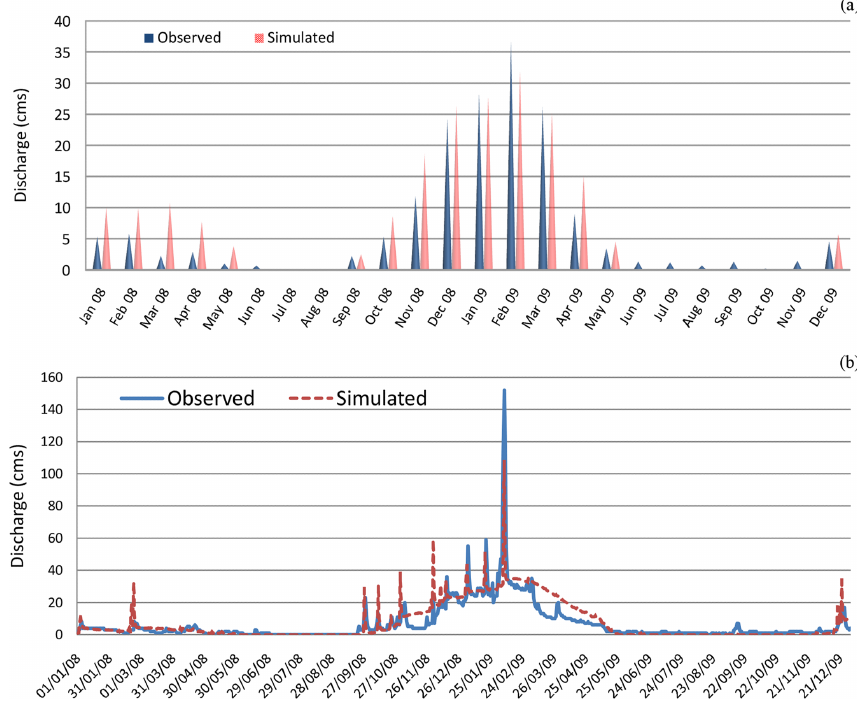
Figure 3. Observed Vs predicted monthly (a) and daily (b) discharge during the validation period at the Souk Elhad flow gage.